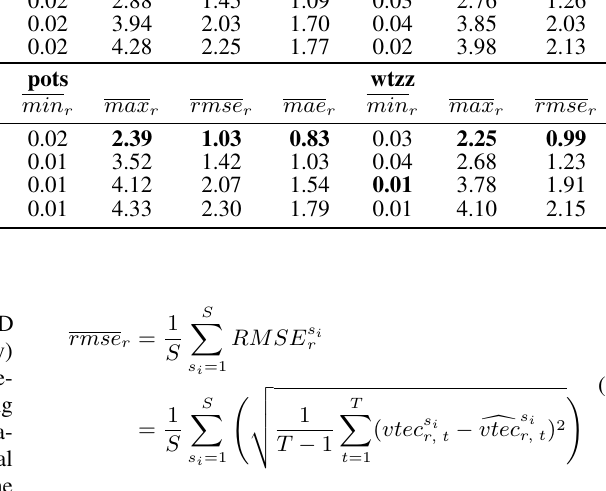
Table 2. A comparative table that summarizes the performance achieved by the CONV1D network in predicting the VTEC (TECU) values over the site stations (bor1, ganp, graz, leij, pots and wtzz). Site bor1 ganp graz Metric mae r min r max r rmse r mae r min r max r rmse r mae r CONV1D